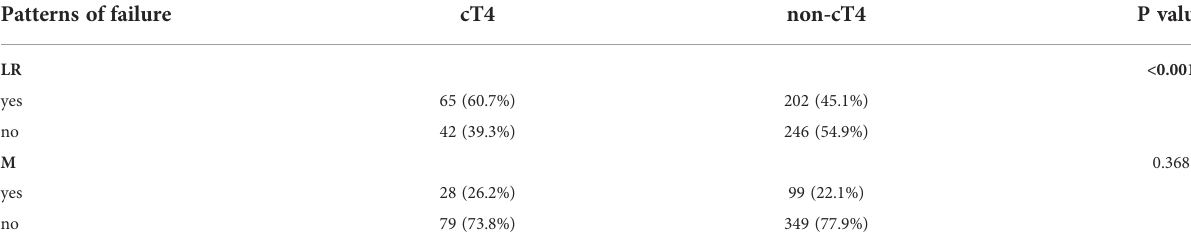
TABLE 2 Correlation between cT stage and patterns of failure. Patterns of failure